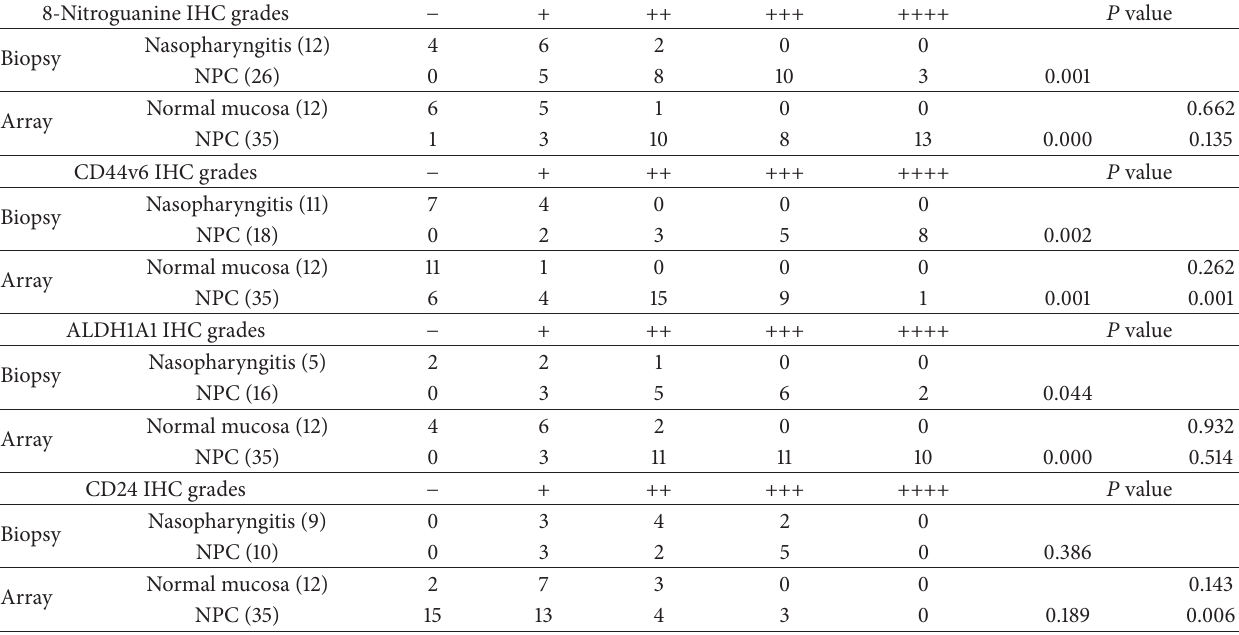
Table 1: IHC grades of biomarkers in nasopharynx